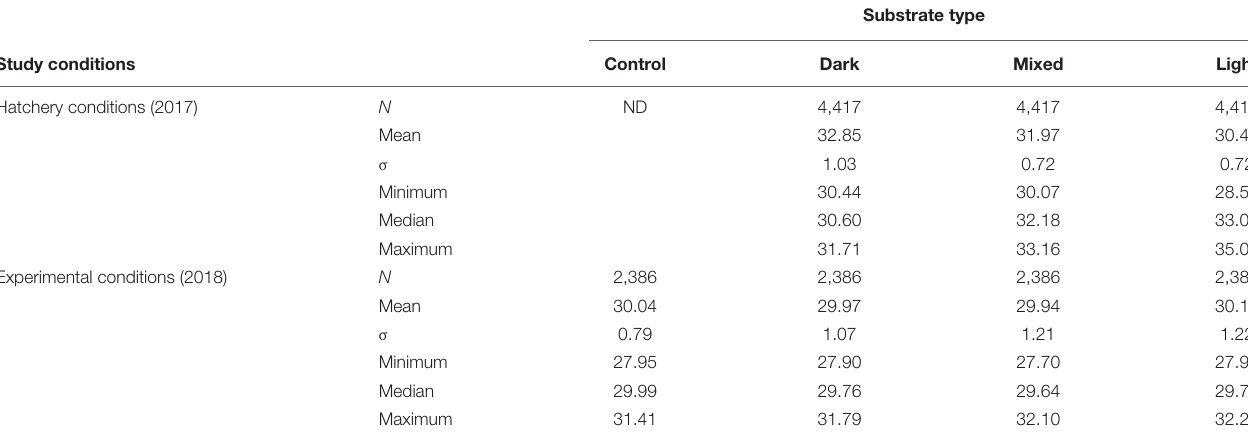
FIGURE 4 | Hatchling self-righting time (time needed to recover the face-down position) in different substrates (dark, mixed, and light) under controlled incubation conditions in the hatchery. Different lowercase letters indicate statistically significant differences among treatments. The median is the bold line as a measure of central tendency, quartiles one (Q1) and three (Q3) marked by upper and lower box limits and maximum (max) and minimum (min) values marked with whiskers above and below. TABLE 2 | Temperatures recorded in three types of substrates in two study conditions (hatchery and